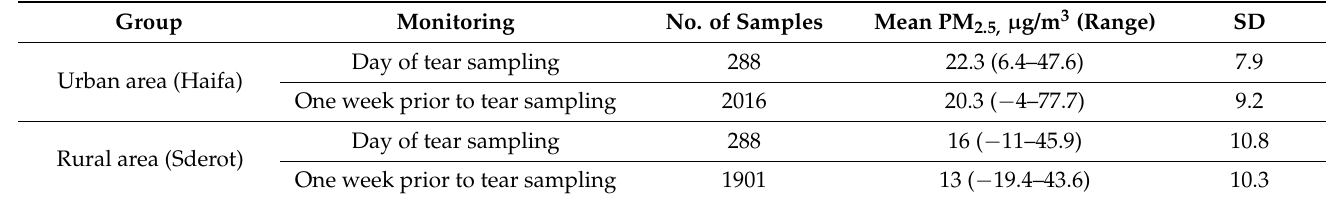
Table 2. PM 2.5 particle concentration data (National Air Monitoring Program, Israel Ministry of Environmental